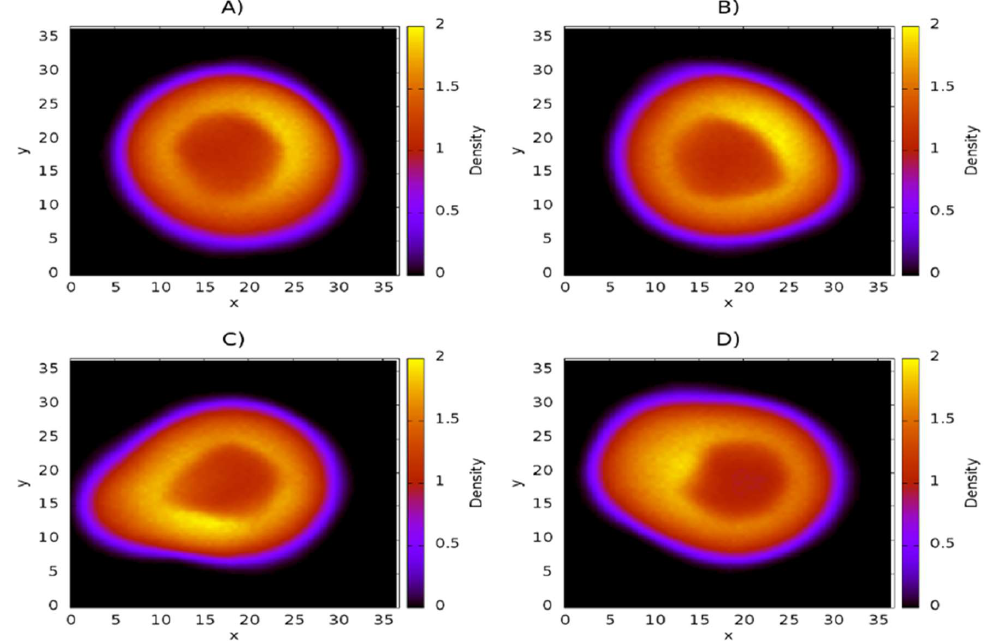
Figure 3. Density maps of lecithin on the xy plane at different concentration of CS. ( A ) 50 chains of CS (6 mM); ( B ) 100 chains of CS (12 mM); ( C ) 150 chains of CS (18 mM); ( D ) 200 chains of CS (24 mM). The scale of density bars starts at 0.0 (black regions) and reaches a maximum of 2.0 (yellow regions). All quantities are expressed in reduced dissipative particle dynamics (DPD) units.